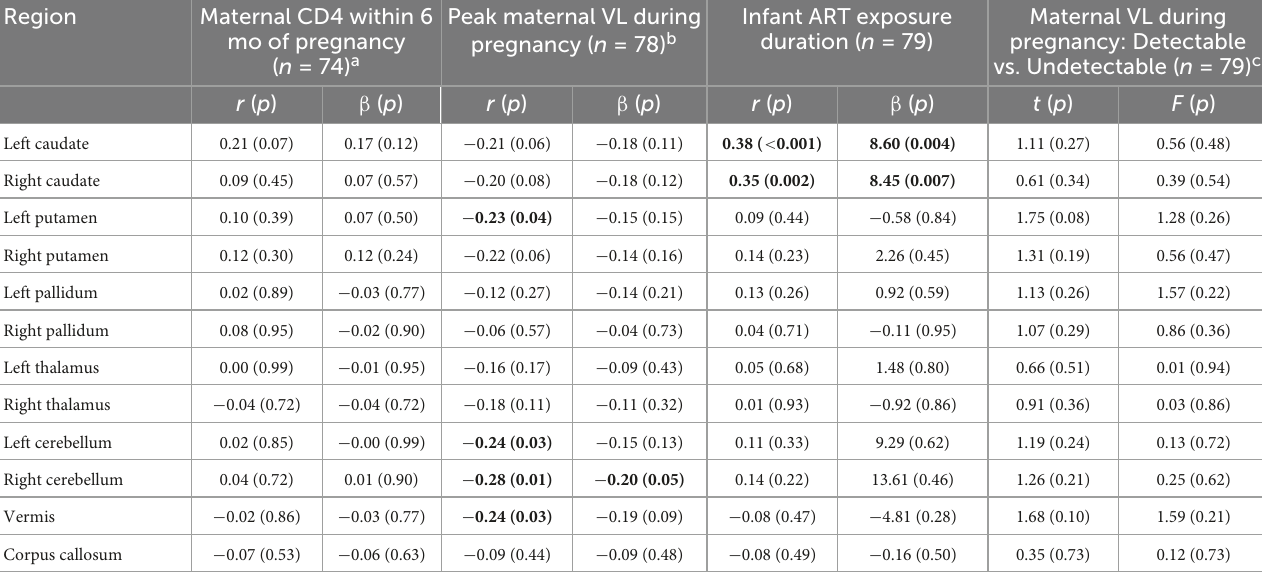
TABLE 4 Associations of regional volumes with maternal clinical and treatment variables in infants with perinatal HIV/ART exposure. Region Maternal CD4 within 6 mo of pregnancy